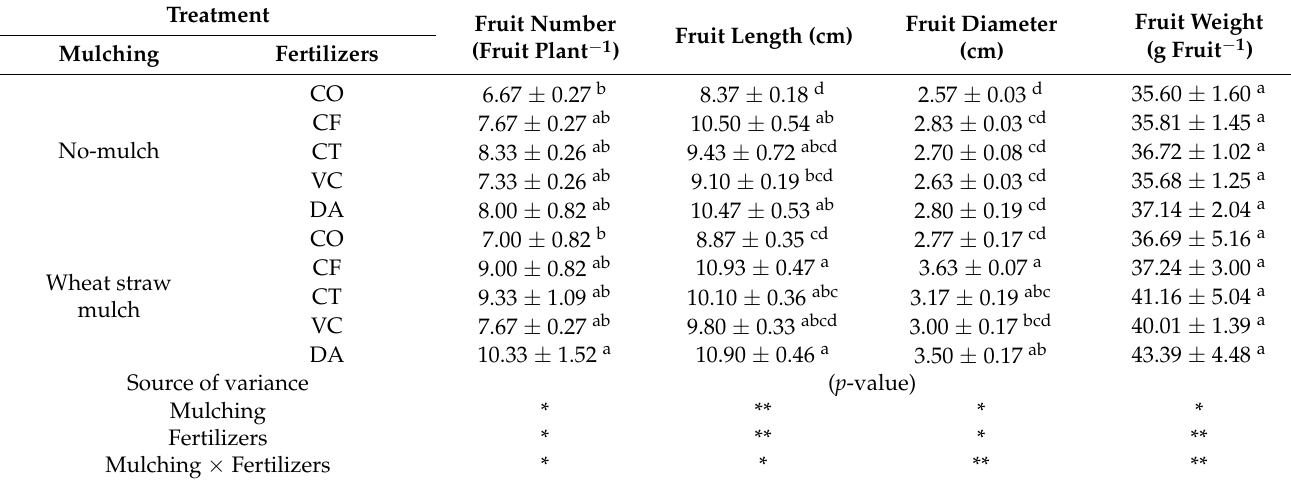
Table 4. Effects of different organic fertilizers and mulching system on squash yield and its components. Treatment Fruit Number